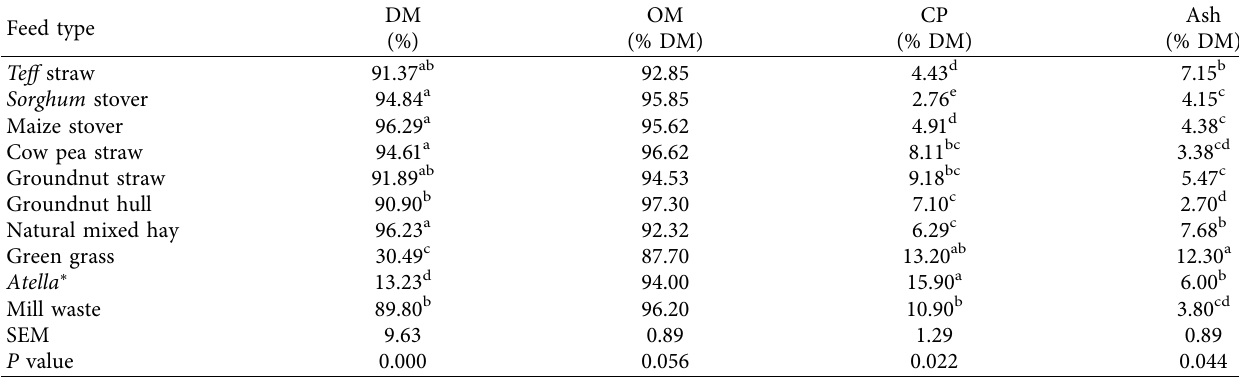
Table 1: Chemical composition of major feed resources available in the study